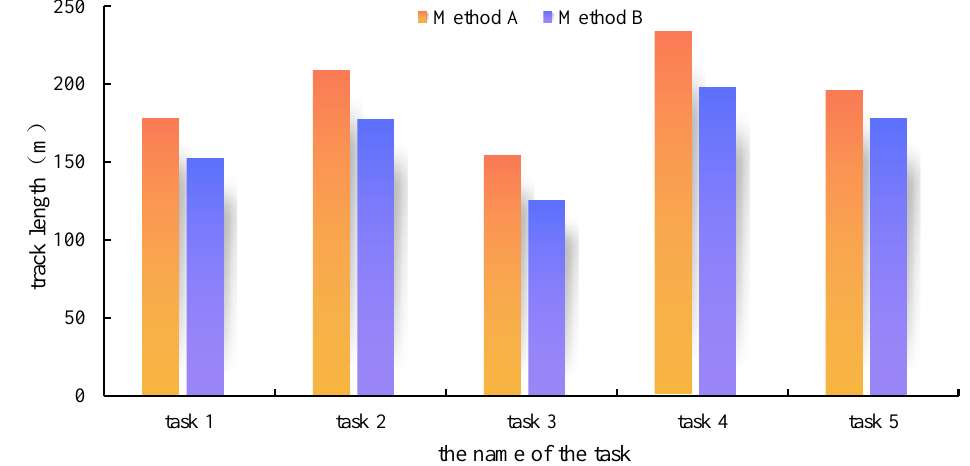
Figure 5. Optimal flight path planning lengths for five flight missions under two methods.